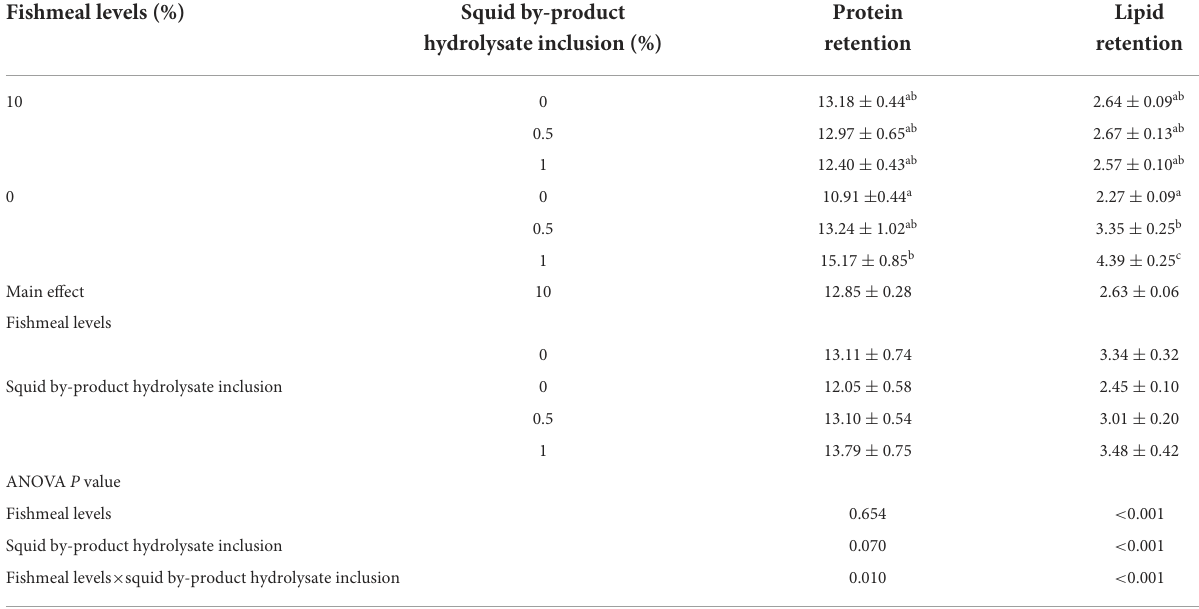
TABLE 7 Nutrient retention of shrimp fed with plant protein-based diets supplemented with squid by-product hydrolysate (% dry weight). Fishmeal levels (%) Squid by-product